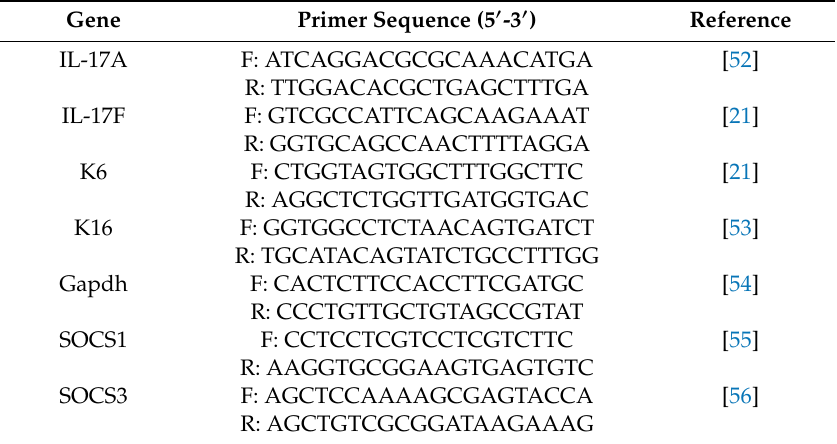
Table 1. Primers used for real-time